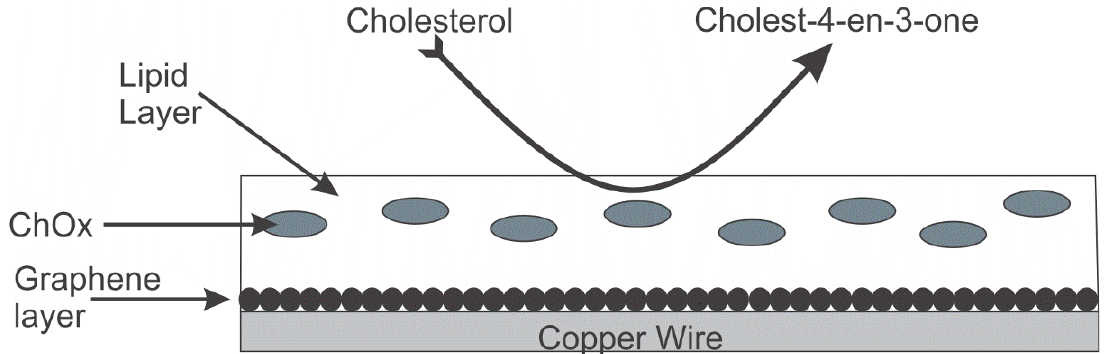
Figure 1. Scheme of the biosensor